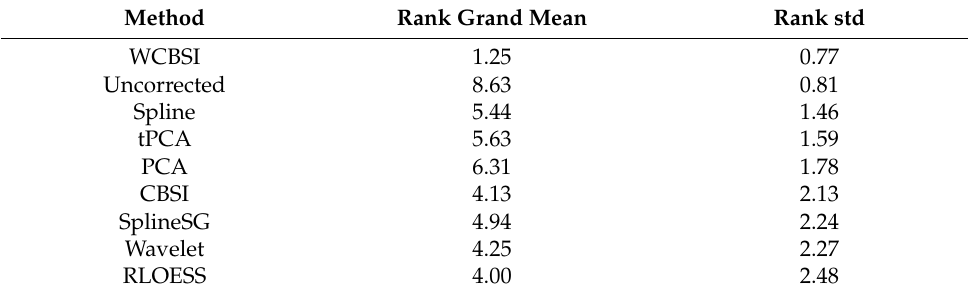
Table 3. Correction methods sorted by standard deviation of rank.